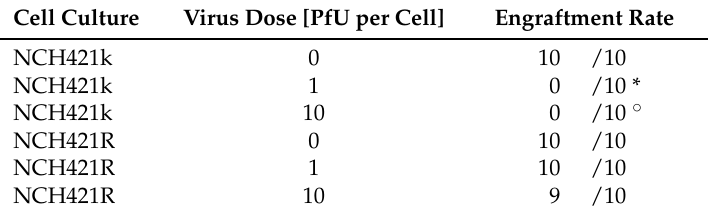
Table 3. Engraftment of glioma “stem-like” NCH421k cells is prevented by H-1PV